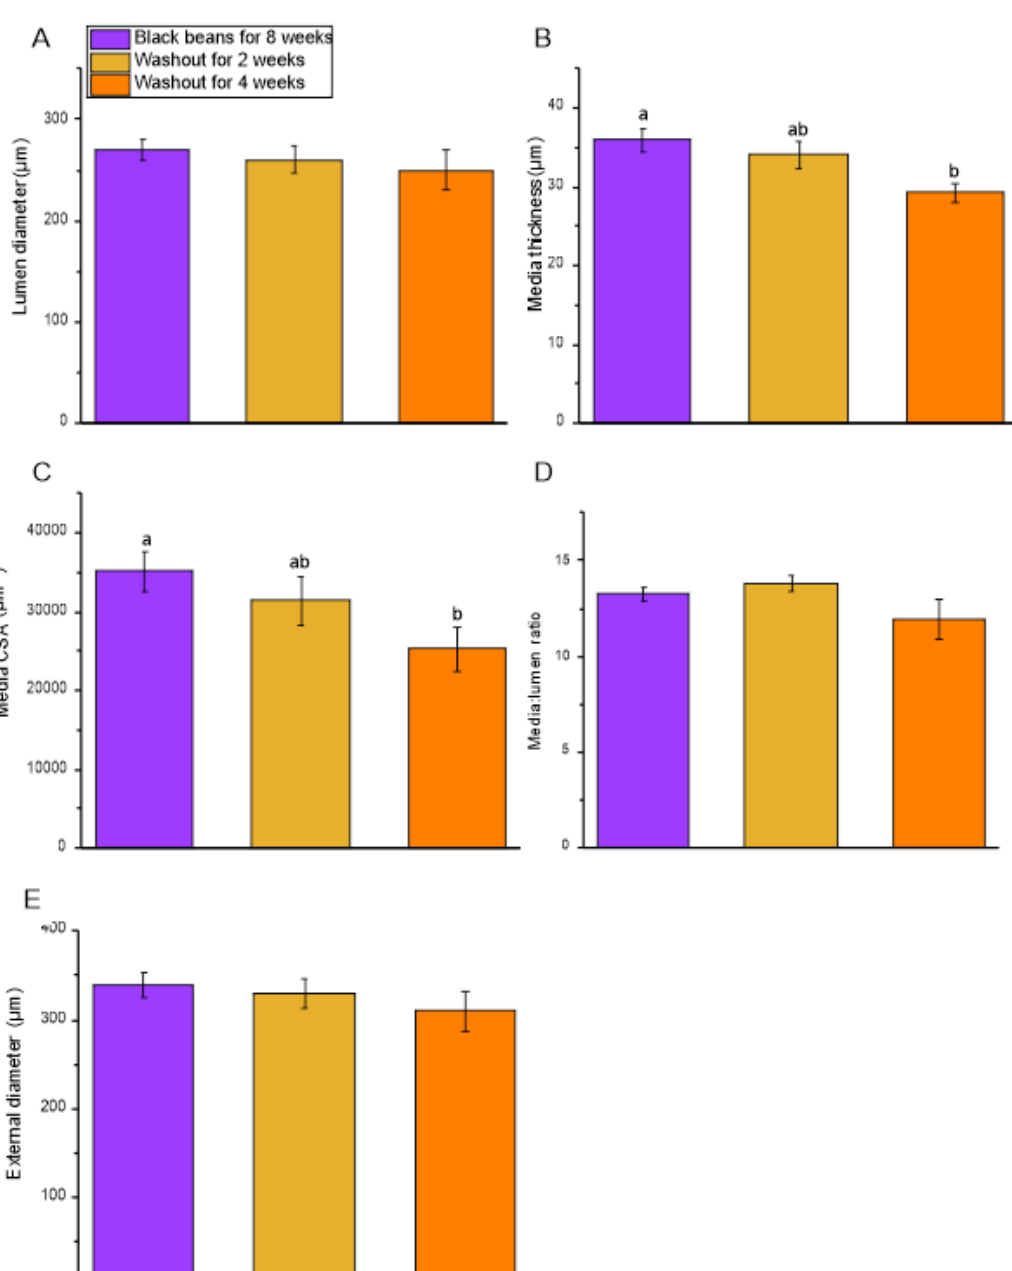
Figure 6. Phase 2: Small-artery geometry in SHR. (A) Lumen diameter; (B) Media thickness; (C) Media CSA; (D) Media:lumen ratio; (E) External diameter. Vascular geometry measurements of mesenteric resistance arteries calculated from data obtained at 45 mmHg on the pressure myograph. Data are expressed as mean ± SEM ( n = 4–9/group). Different letters represent significant differences ( p < 0.05). An absence of letters indicates no statistical differences. Abbreviations : CSA, cross-sectional area; SHR, spontaneously hypertensive rat.